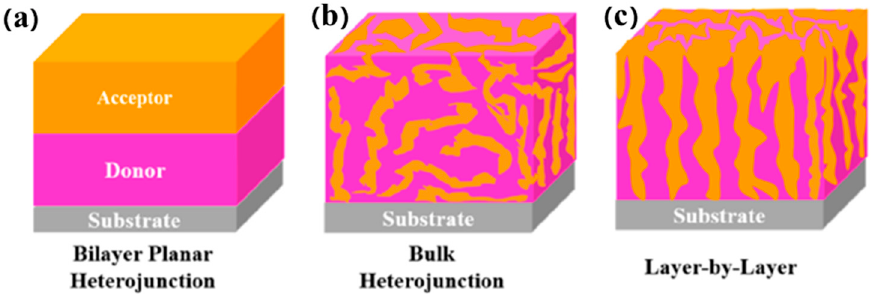
Figure 1. Schematic architecture of ( a ) Bilayer planar heterojunction, ( b ) Bulk heterojunction, and ( c ) Layer-by-layer. Adapted with permission from Ref. [41]. Copyright 2021 American Chemical Society.